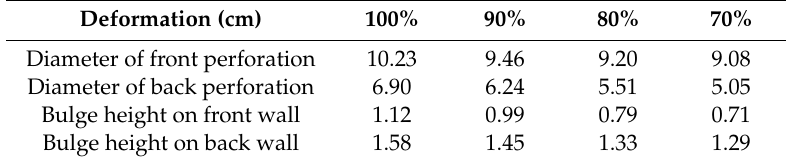
Table 6. Perforation diameters and bulge heights at di ff erent liquid-filling ratios. Deformation